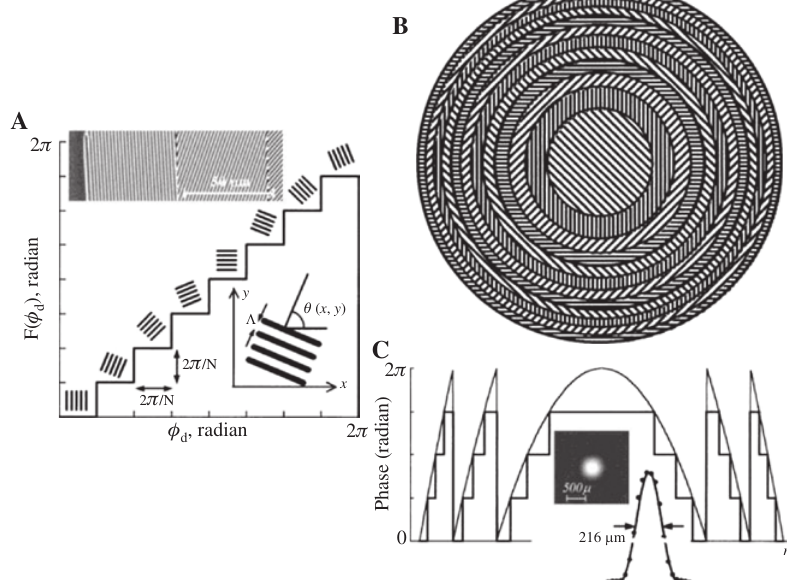
Figure 14: (A) The relationship between the designed phase and the discrete local grating orientation. Inset is the SEM image of a region on the subwavelength structure of the focusing lens. (B) Illustration of a PB phase lens with varying subwavelength structures in the radial direction. (C) The geometric phase distribution and the measured light spot. Inset is the measured (dots) and calculated intensity (solid curve) cross section. Adapted from Ref.